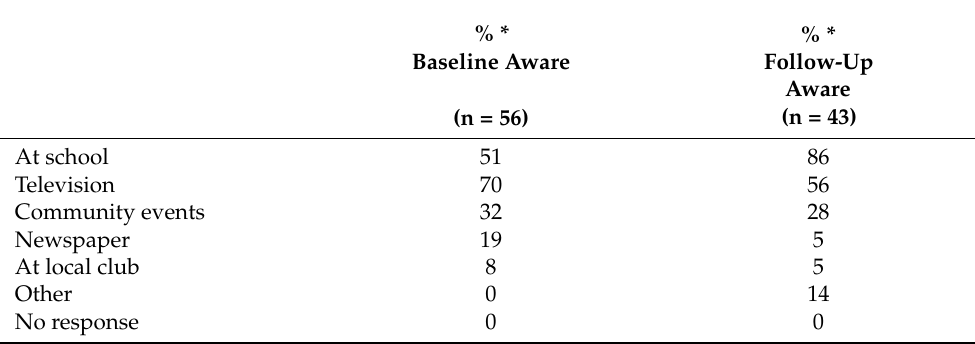
Table 1. Sources of awareness of